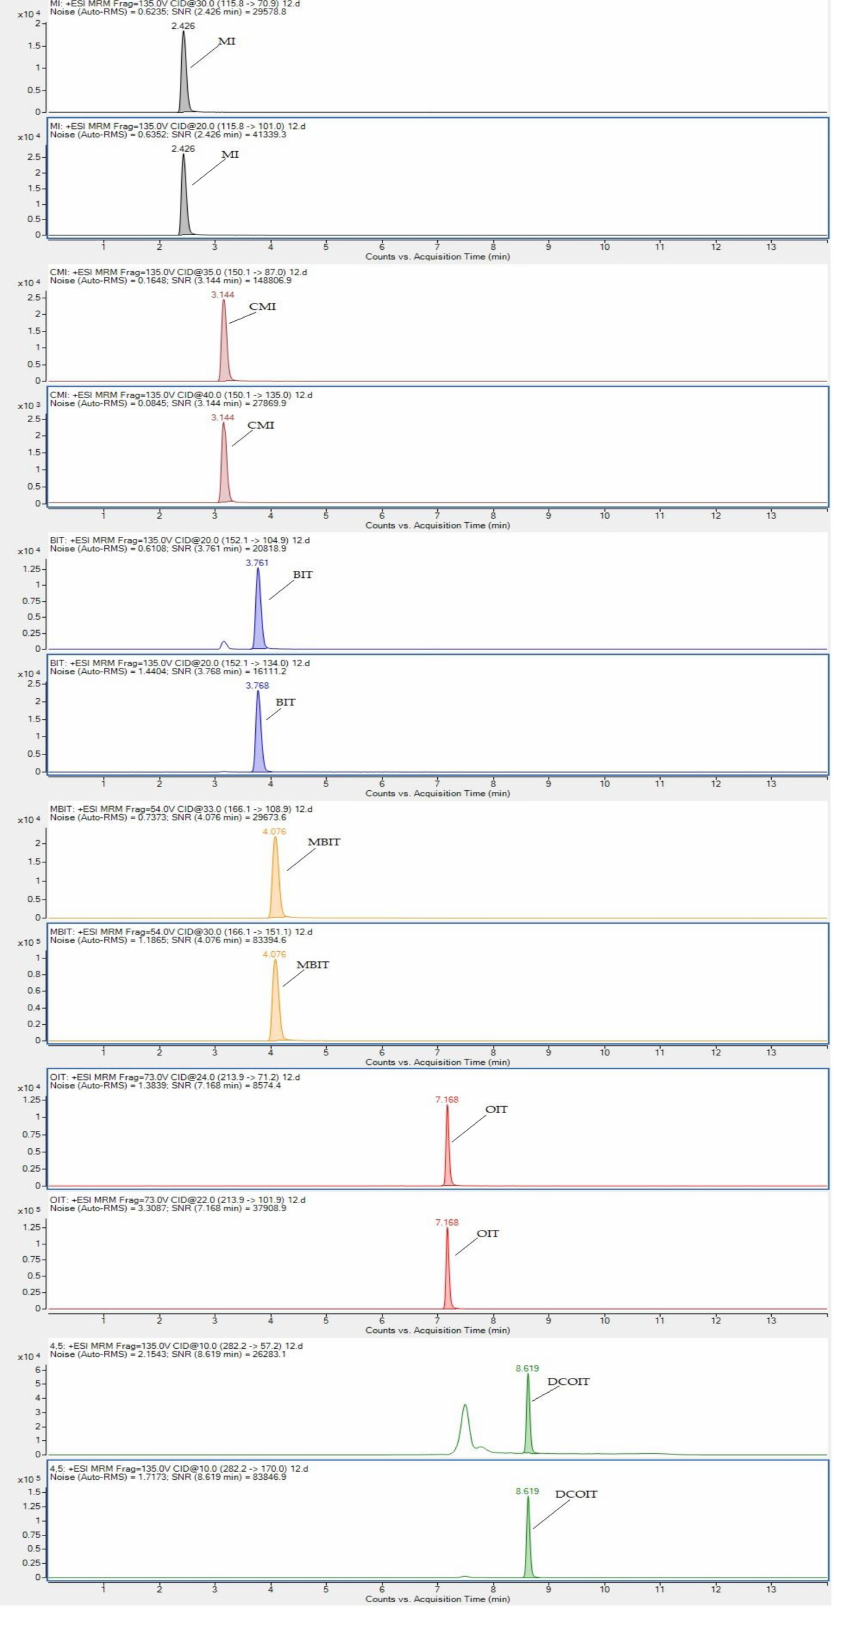
Figure 6. The MRM chromatograms of each targeted isothiazolinone (1.00 mg /